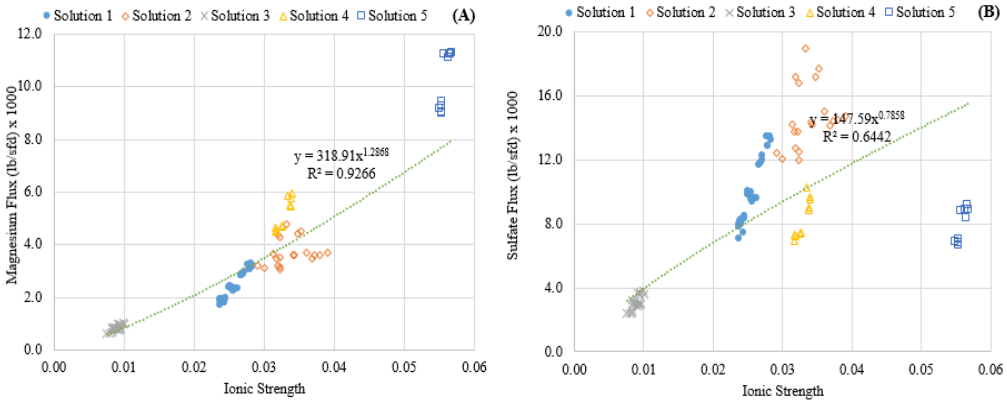
Figure 3. Effect of ionic strength on ion flux. ( A ) Magnesium; ( B ) Sulfate.